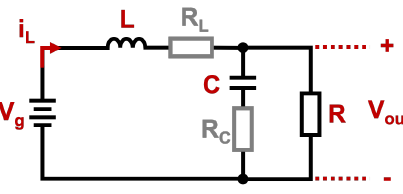
Figure 9. Buck converter equivalent model when the transistor is ON.